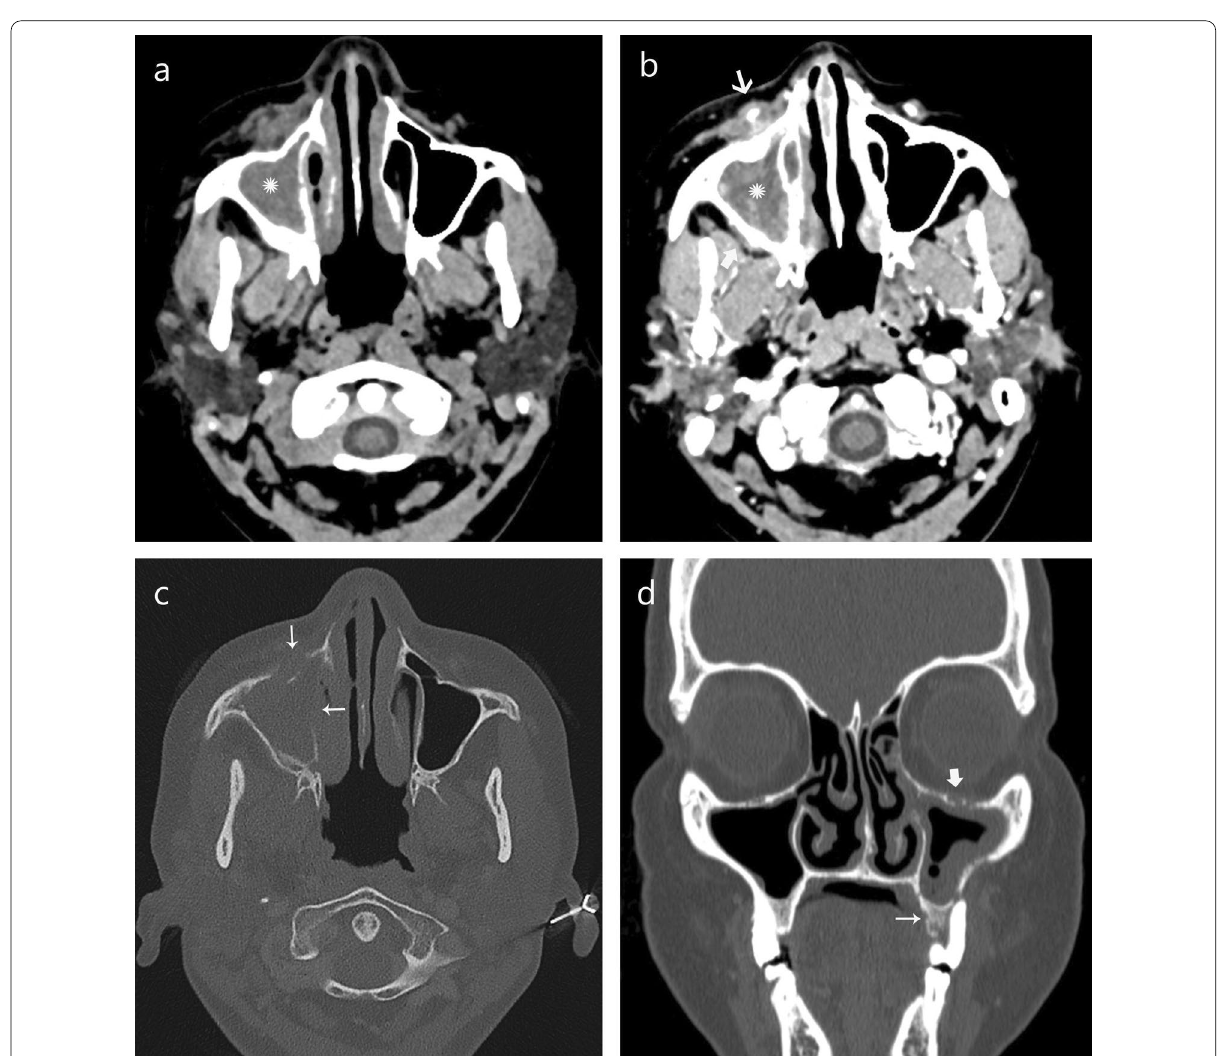
Fig. 1 Computed tomography findings in mucormycosis. a Non-contrast and b contrast enhanced CT scan demonstrates hypodense soft tissue obliteration of right maxillary sinus (*) with heterogeneous, patchy mucosal enhancement and enhancing foci in cavity with inflammatory changes in premaxillary (thin arrow), retroantral fat (thick arrow) and facial muscles. c CT scan 20 days later shows extensive erosion of anterior and medial walls of maxillary antrum (arrows). d Coronal view of face shows mucosal thickening of left maxillary and anterior ethmoidal air cells, obliteration of the osteo-meatal complex, erosion of maxillary antrum (superior and lateral wall) and alveolar arch (thin arrow) along gingivo-buccal sulcus against 2 nd upper molar. The left infraorbital foramen is thickened suggesting perineural spread along infraorbital nerve (thick